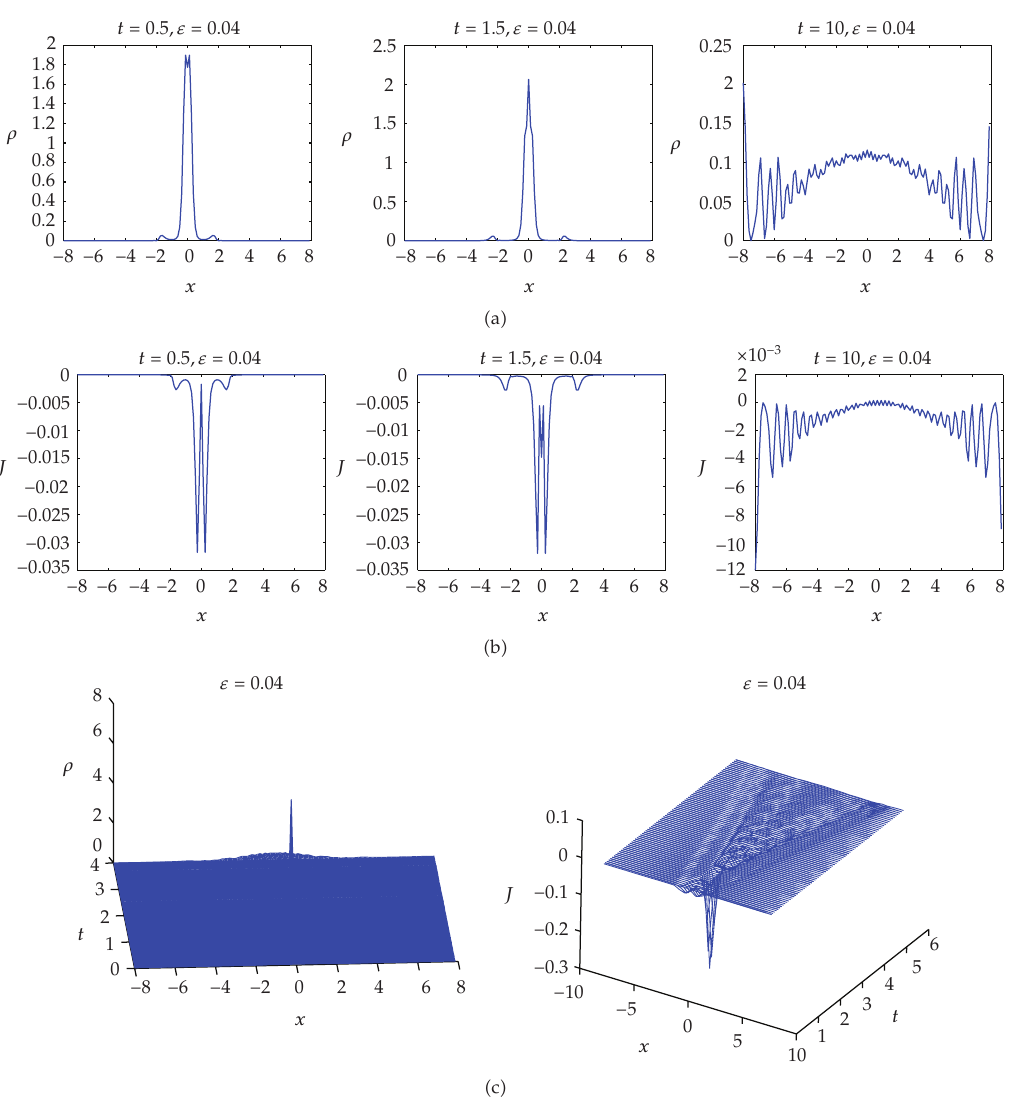
Example 5.1 (cid:3) weak O (cid:3) ε (cid:4) cubic defocusing nonlinearity (cid:4) . The initial condition is taken